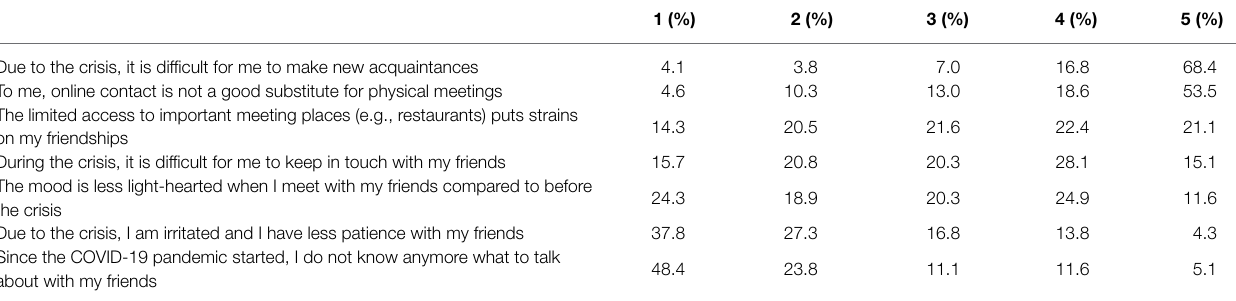
TABLE 1 | Percentages of participants experiencing different challenges for their friendships due to the COVID-19 crisis.